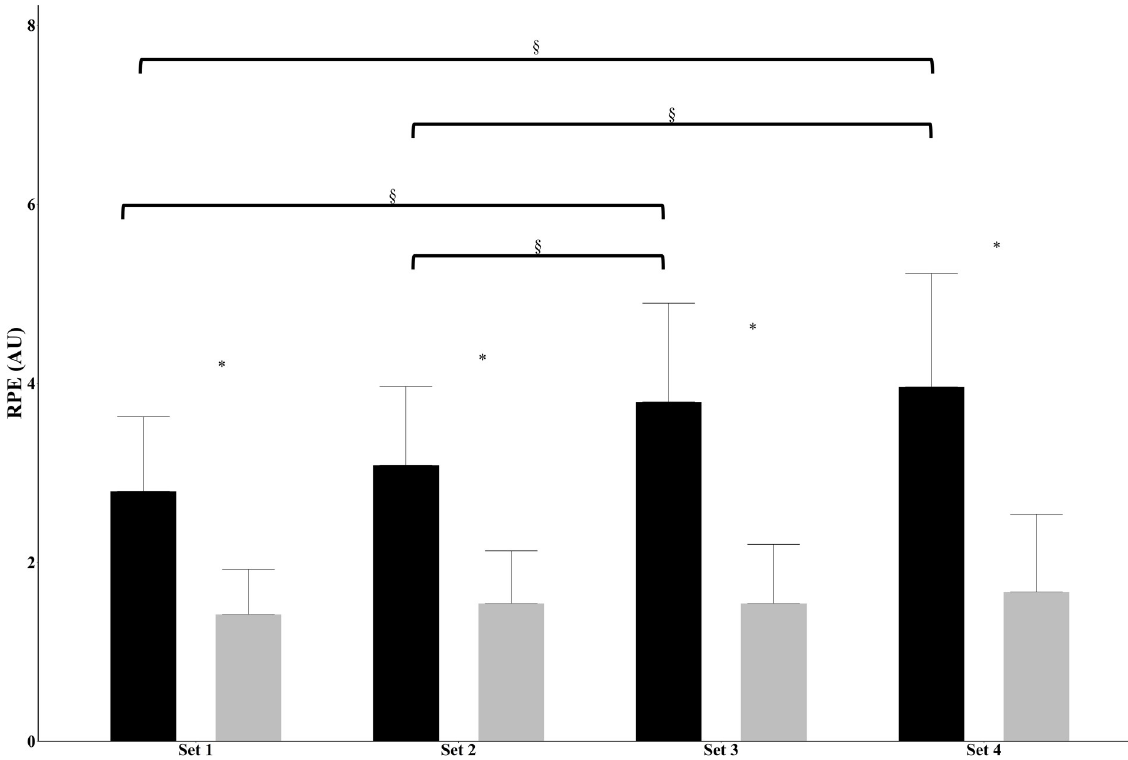
Fig 3. Muscle rating of perceived exertion between conditions and time. Data represent mean ± SD and collapsed across sex (BFR: black bars, CON: grey bars). SD: Standard deviation. � significant differences between conditions at indicated timepoint, collapsed across sex; §significant difference between